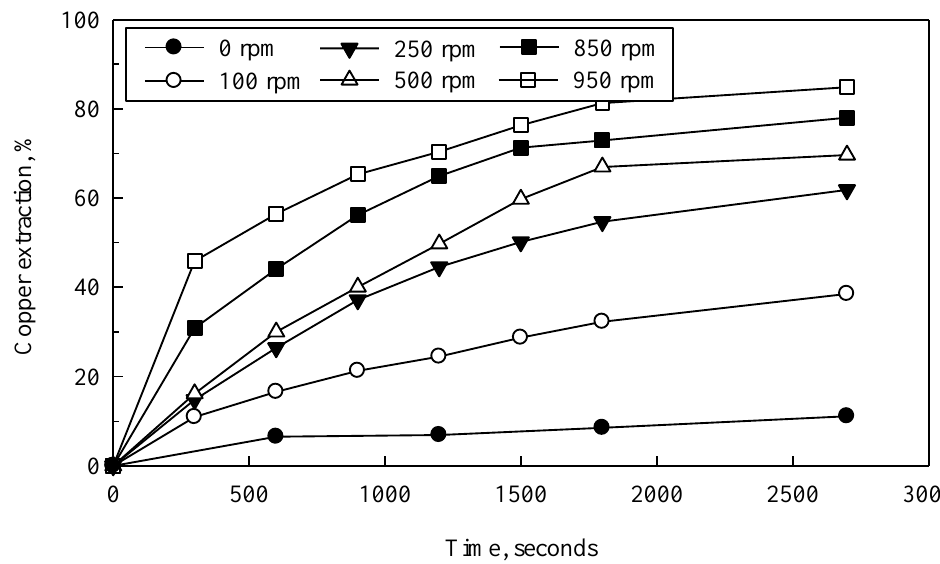
Figure 4. Analysis of the agitation rate of the solution as a function of time. Working conditions: pH = 10.5, [NH 4 OH] = 0.7 mol/dm 3 , T = 298K, PS = 64 m, ratio = 1000/1.